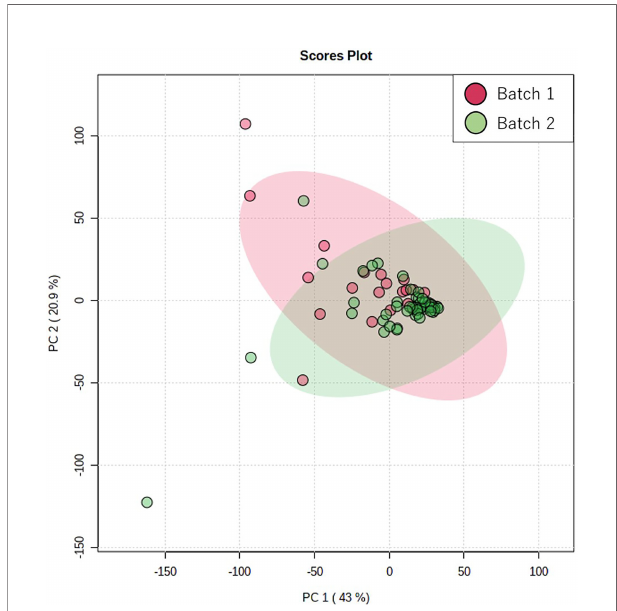
FIGURE 1 | Score plots of principal component analysis using Pareto scaling PC1 and PC2 indicate the fi rst and second principal components, respectively. The red and green plots indicate the samples collected in batches 1 and 2, respectively. The contribution rates of PC1 and PC2 were 43.1% and 20.95%, respectively.